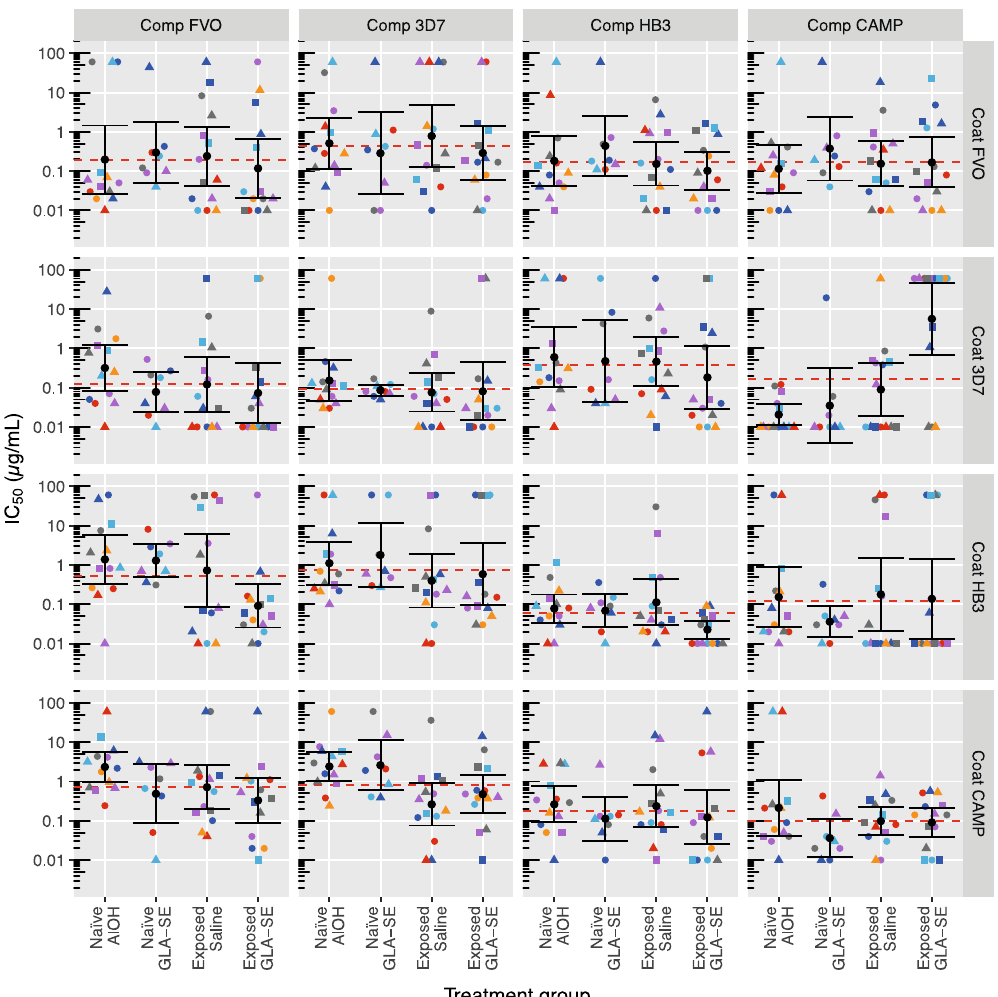
Fig. 4 Competition ELISA IC 50 values 4 weeks after the third vaccination for four natural AMA1 variants in malaria-naive and malaria- exposed adults. Individual IC 50 values 4 weeks after the third vaccination are shown. Colours and shapes within treatment groups indicate individual subjects. Summary statistics (geometric means with 95% con fi dence intervals) are shown in every panel. The red dashed line indicates geometric mean IC 50 values across the four treatment groups. Comp = Competitor antigen, Coat = coating